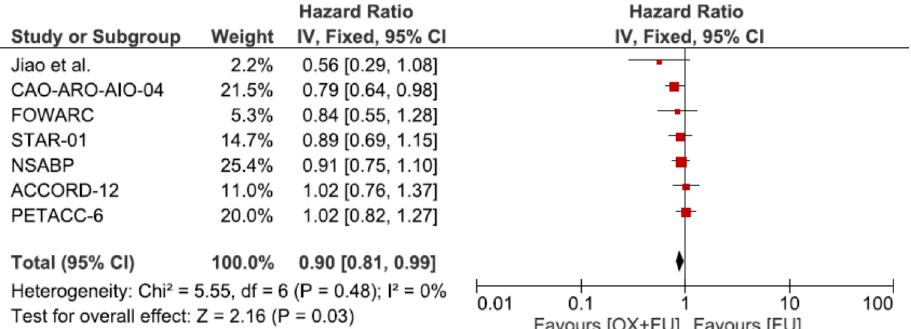
Figure 1. Forest plot of hazard ratio for disease free survival.